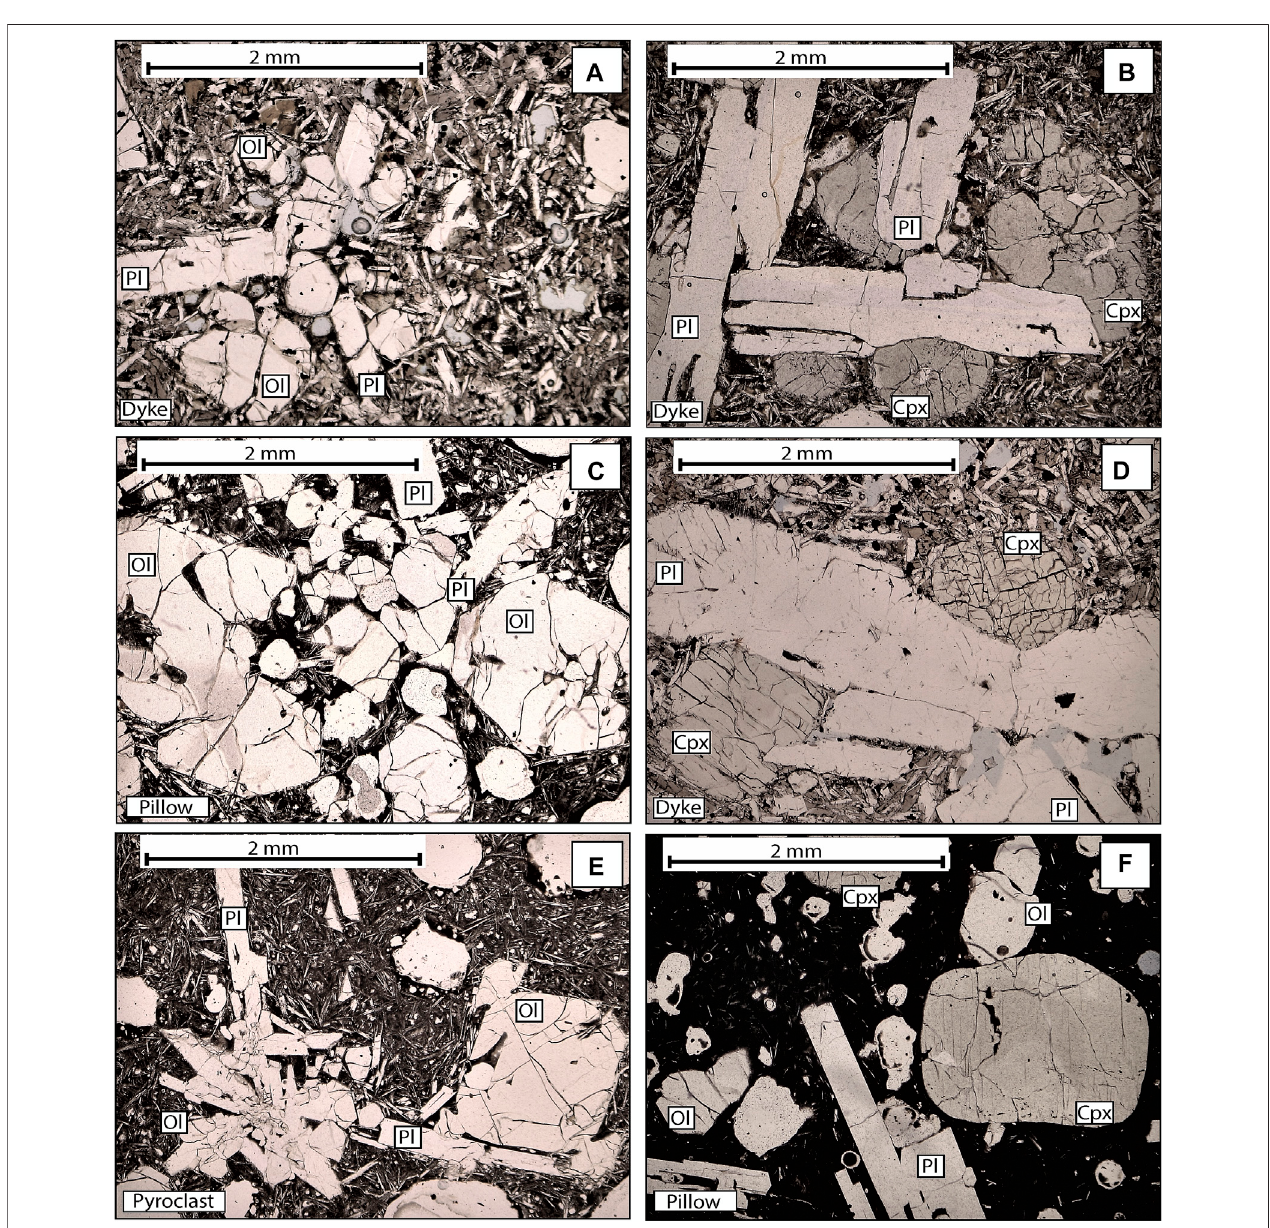
FIGURE 2| Photomicrographs ofthin sections illustrating porphyritic textures ofCM samples. All images are at 4x magni fi cation with ablack 2 mm scale. (A,C,E) , displayexamplesoftheolivine-plagioclasephenocrystsuite(i.e.,OP),while (B,D,F) displayexamplesoftheolivine-plagioclase-augiteporphyriticsamplesuite(i.e.,OPA). Labels indicate volcanic